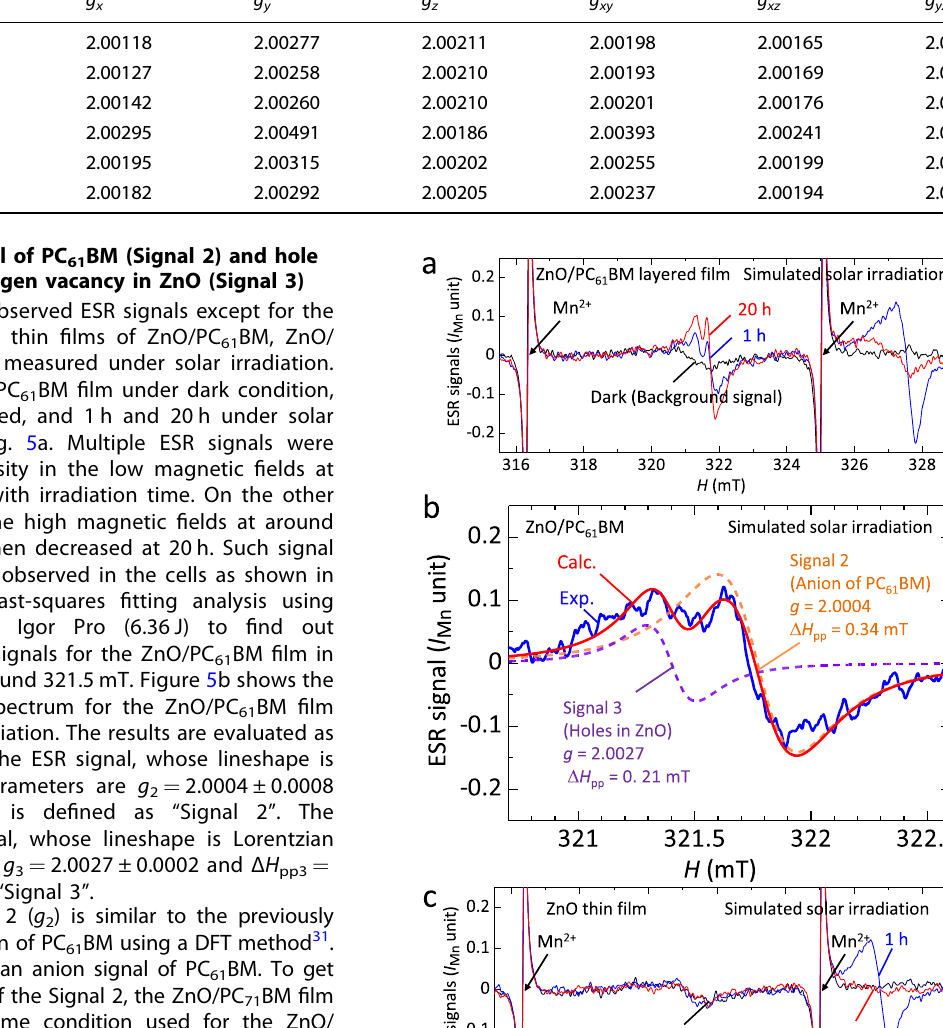
Table 1. Calculated g -tensors ’ principal values and their averaged values of model molecules of PTzBT with and without bromine end. Molecule